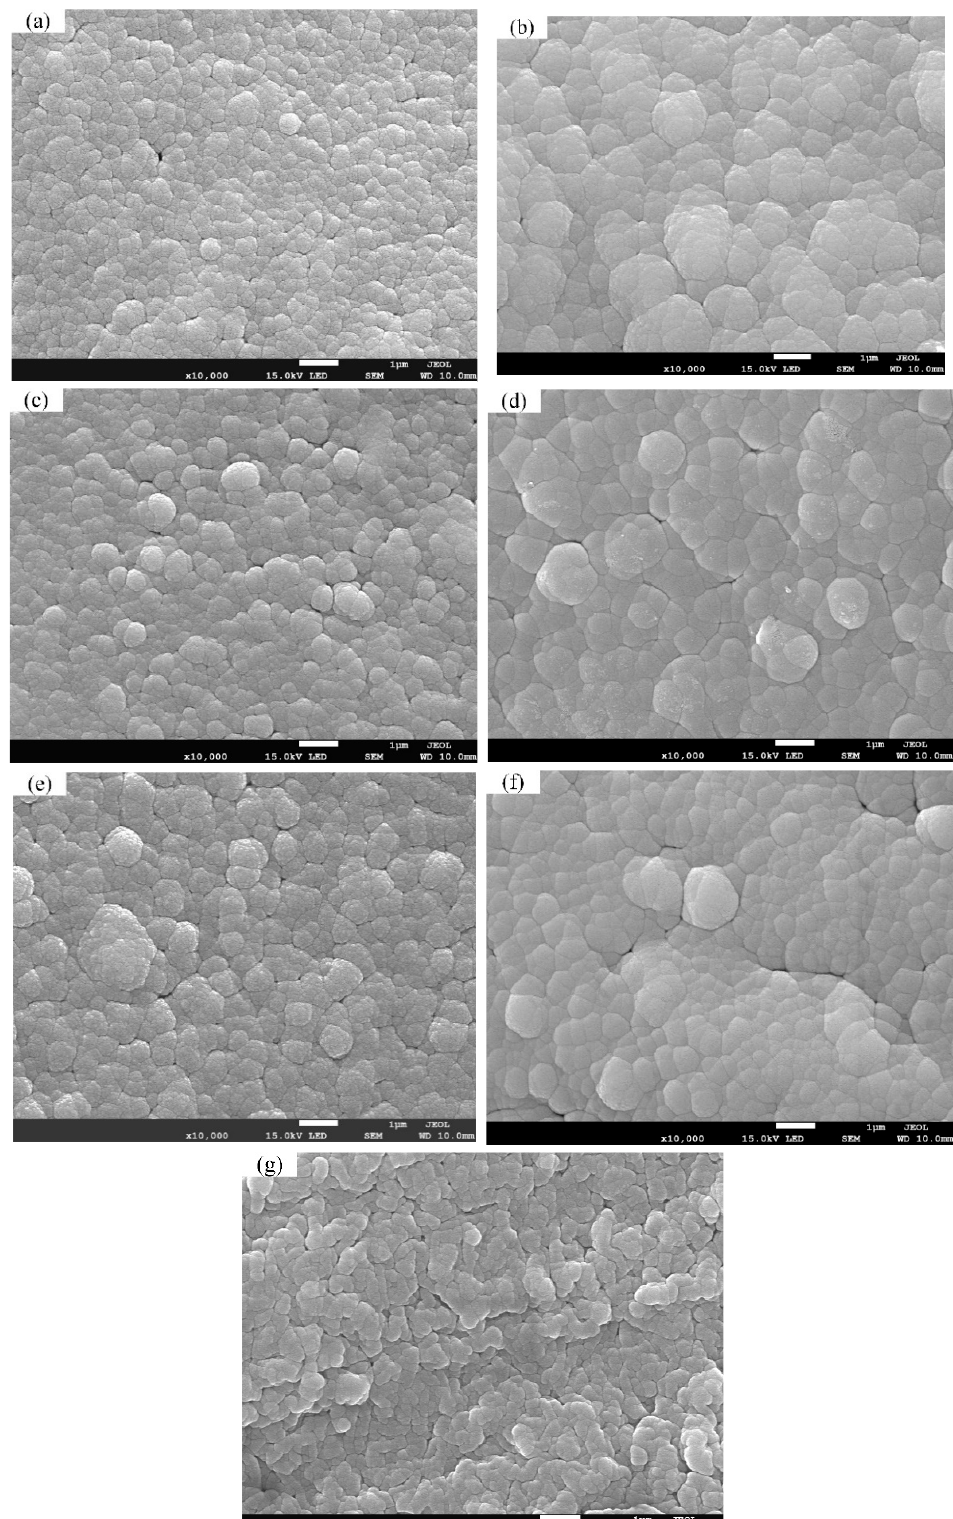
Figure 4. SEM images show microstructure of (Ti:N)-GLC films: ( a ) Ti-C (100); ( b ) Ti-C (200); ( c ) TiC-C (100); ( d ) TiC-C (200); ( e ) TiN-C (100); ( f ) TiN-C (200); ( g ) C (200). (Ti:N)-GLC films all exhibit cauliflower-like microstructure, indicating a columnar growth of films, different from the worm-like microstructure of GLC films.